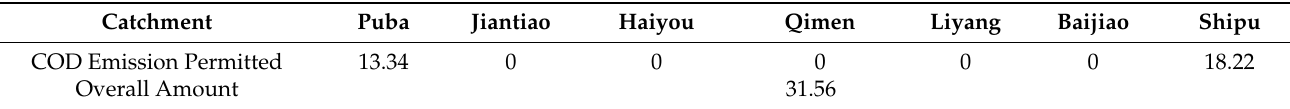
Table 6. Emission permitted of COD ( × 10 4 t / a